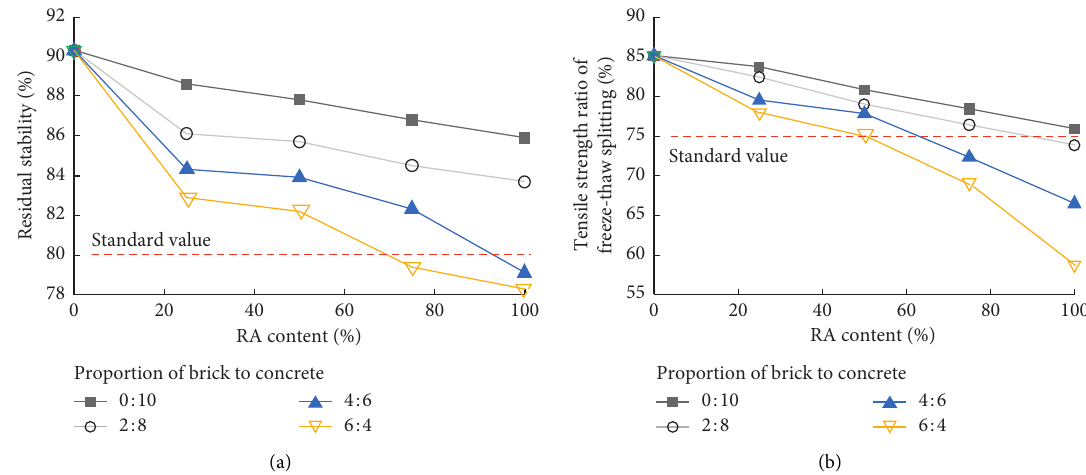
Figure 8: Water stability test results of recycled asphalt mixtures. (a) Residual stability. (b) Freeze-thaw splitting test strength